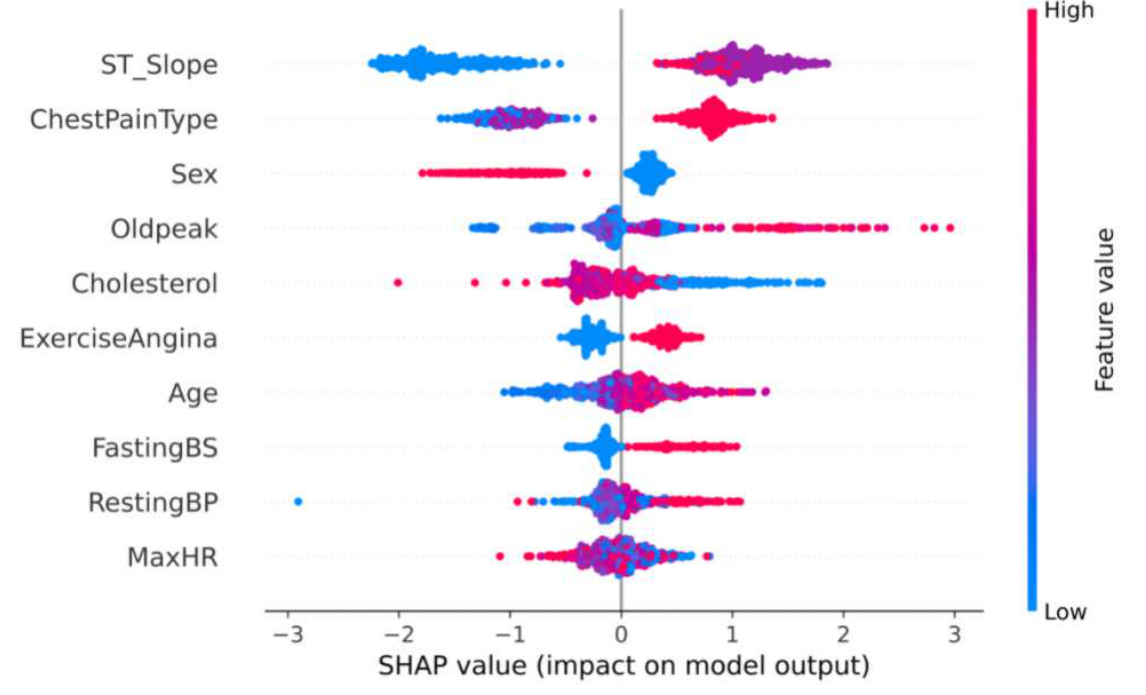
Figure 4. Comparison of individual feature contributions.